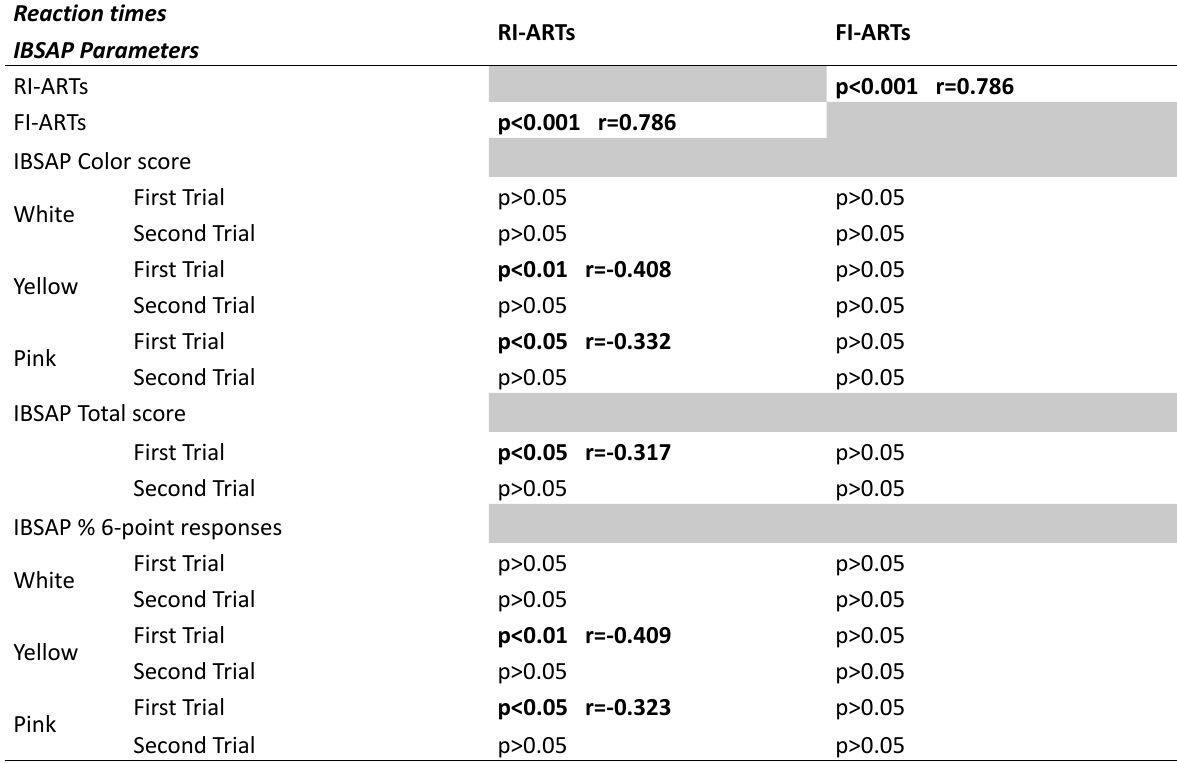
Table 7. Relationships between random interval auditory reaction times (RI-ARTs), fixed interval auditory reaction times (FI-ARTs), and IBSAP